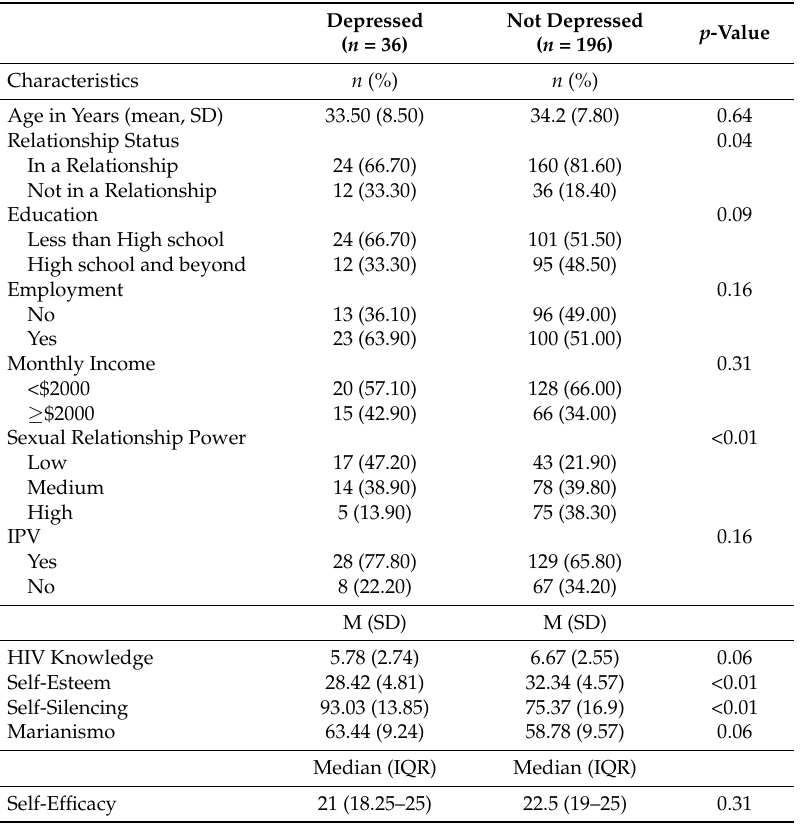
Table 1. Characteristics of adult Latina immigrant farm workers by depression status in SEPA study in Miami-Dade County in South Florida in 2014–2016.